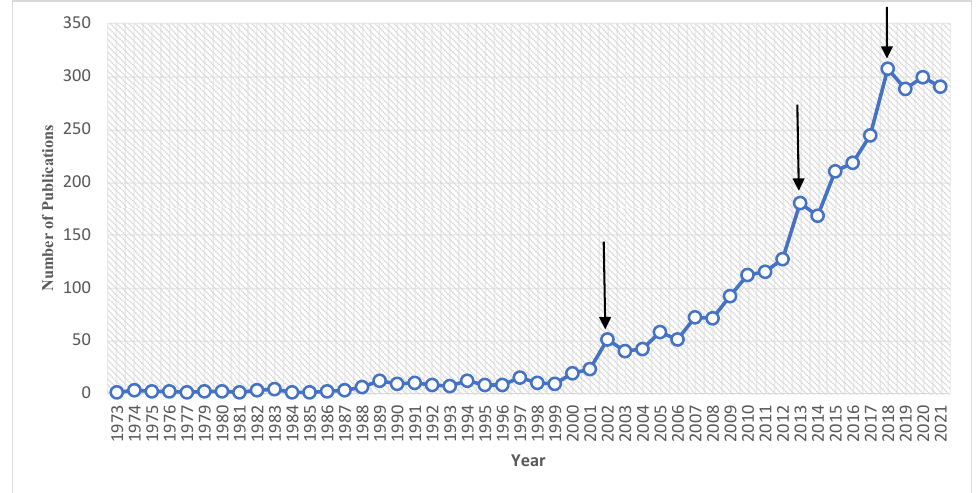
Figure 2. TCS ‐ health ‐ related publications per year. Arrows indicate spikes in the number of publications produced in correlation with significant events in this field (2002, 2013, and 2018).